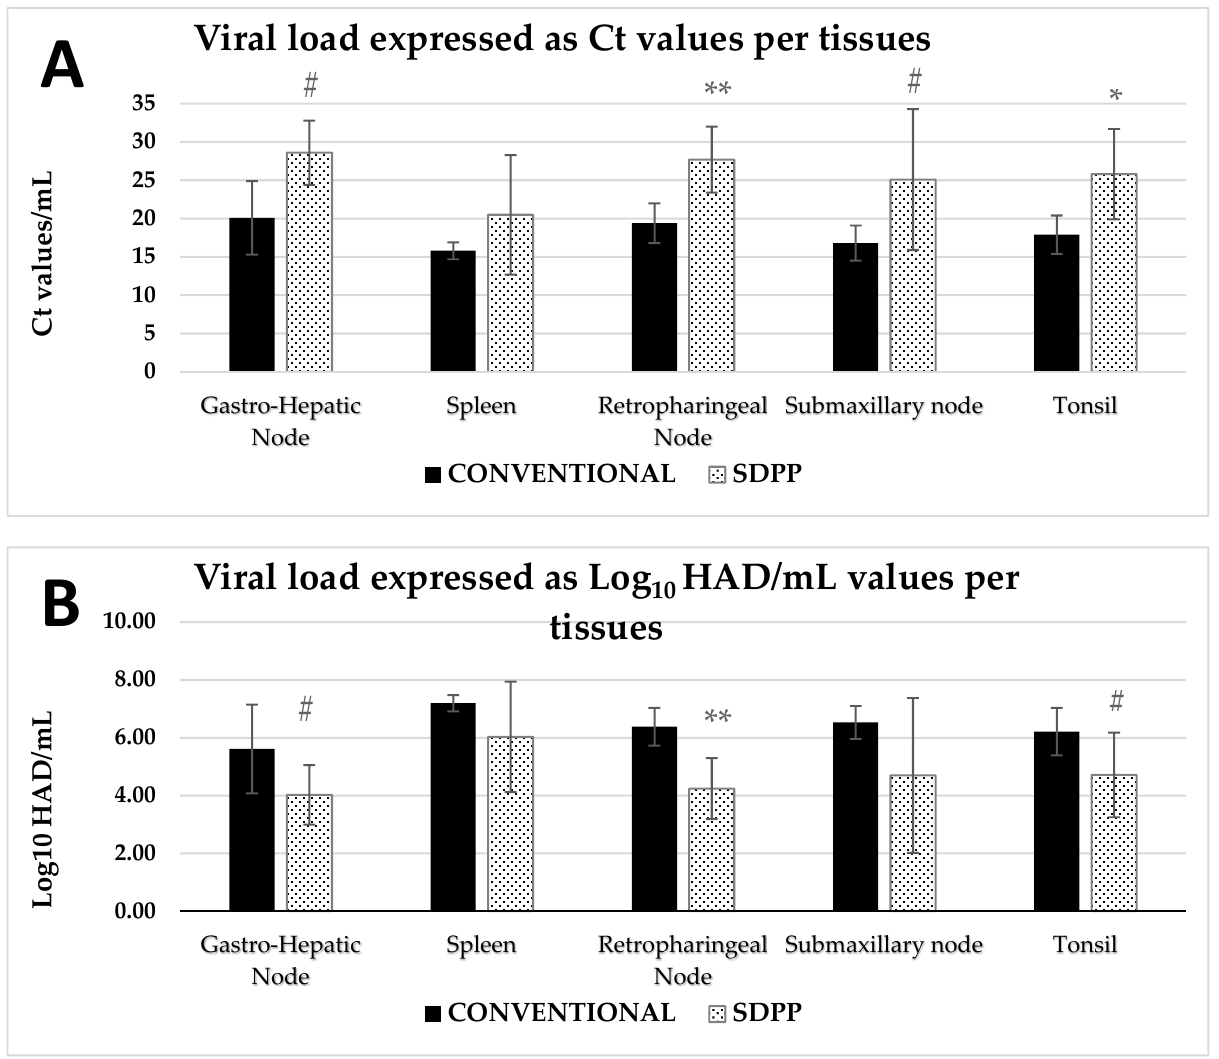
Figure 5. ( A ). Average qRT-PCR results of different tissues at d29pe (d12pse) of the study. Values expressed as Ct values/mL. ( B ). Average viral load expressed as Log 10 HAD/mL in different tissues analyzed at d29pe (d12pse) of the study. # = p < 0.1; * = p < 0.05; ** = p < 0.01 SDPP = spray-dried porcine plasma.